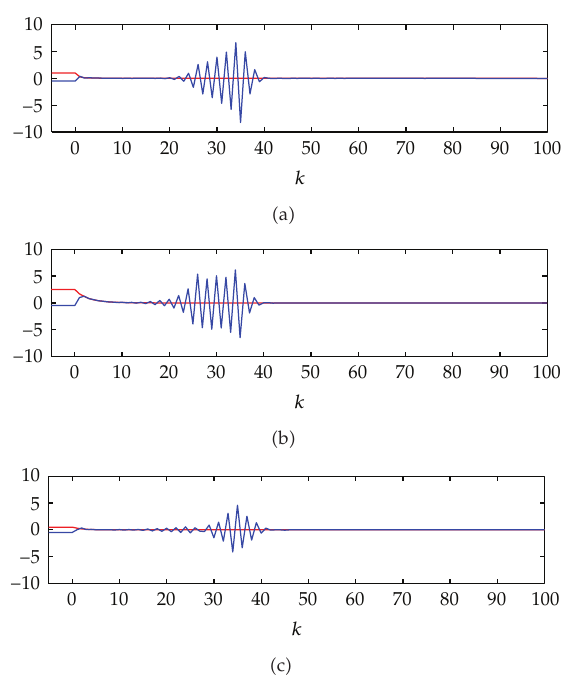
Figure 1: State trajectories of x (cid:2) k (cid:3) , (cid:4) x (cid:2) k (cid:3) .